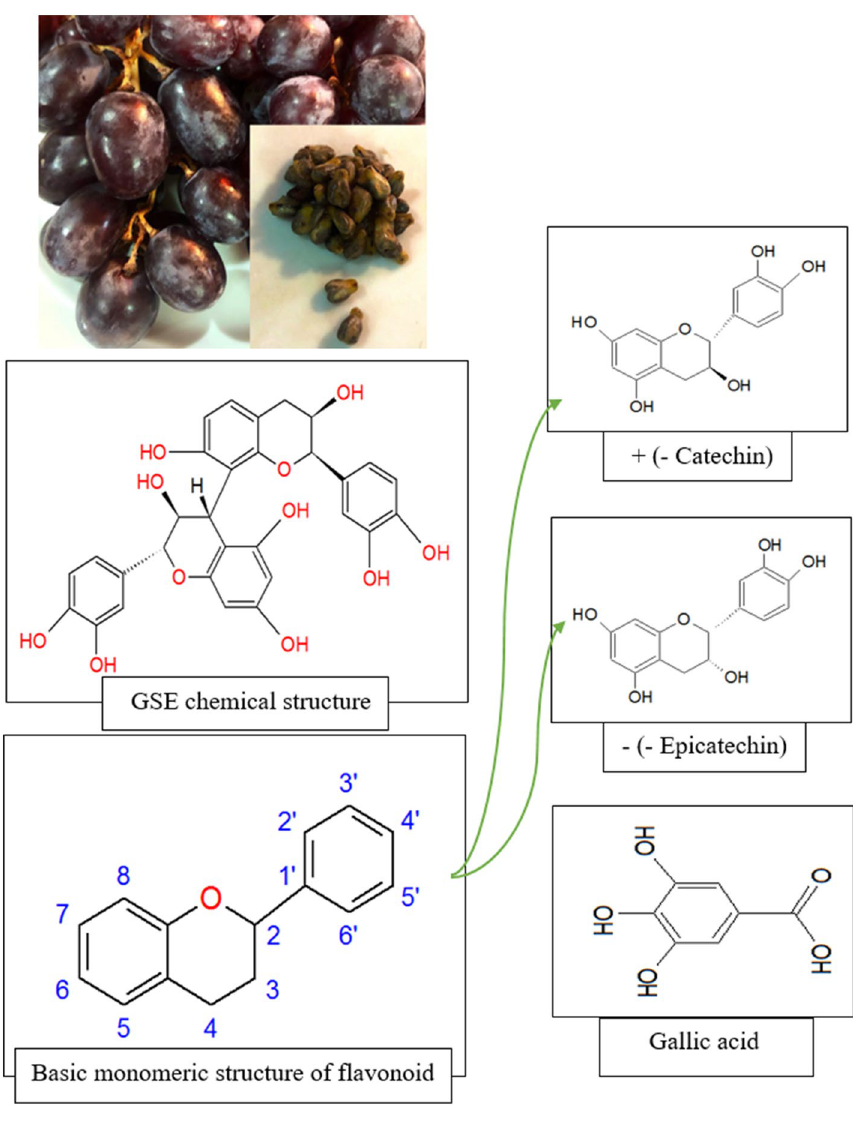
Figure 1. Chemical structure of grape seed